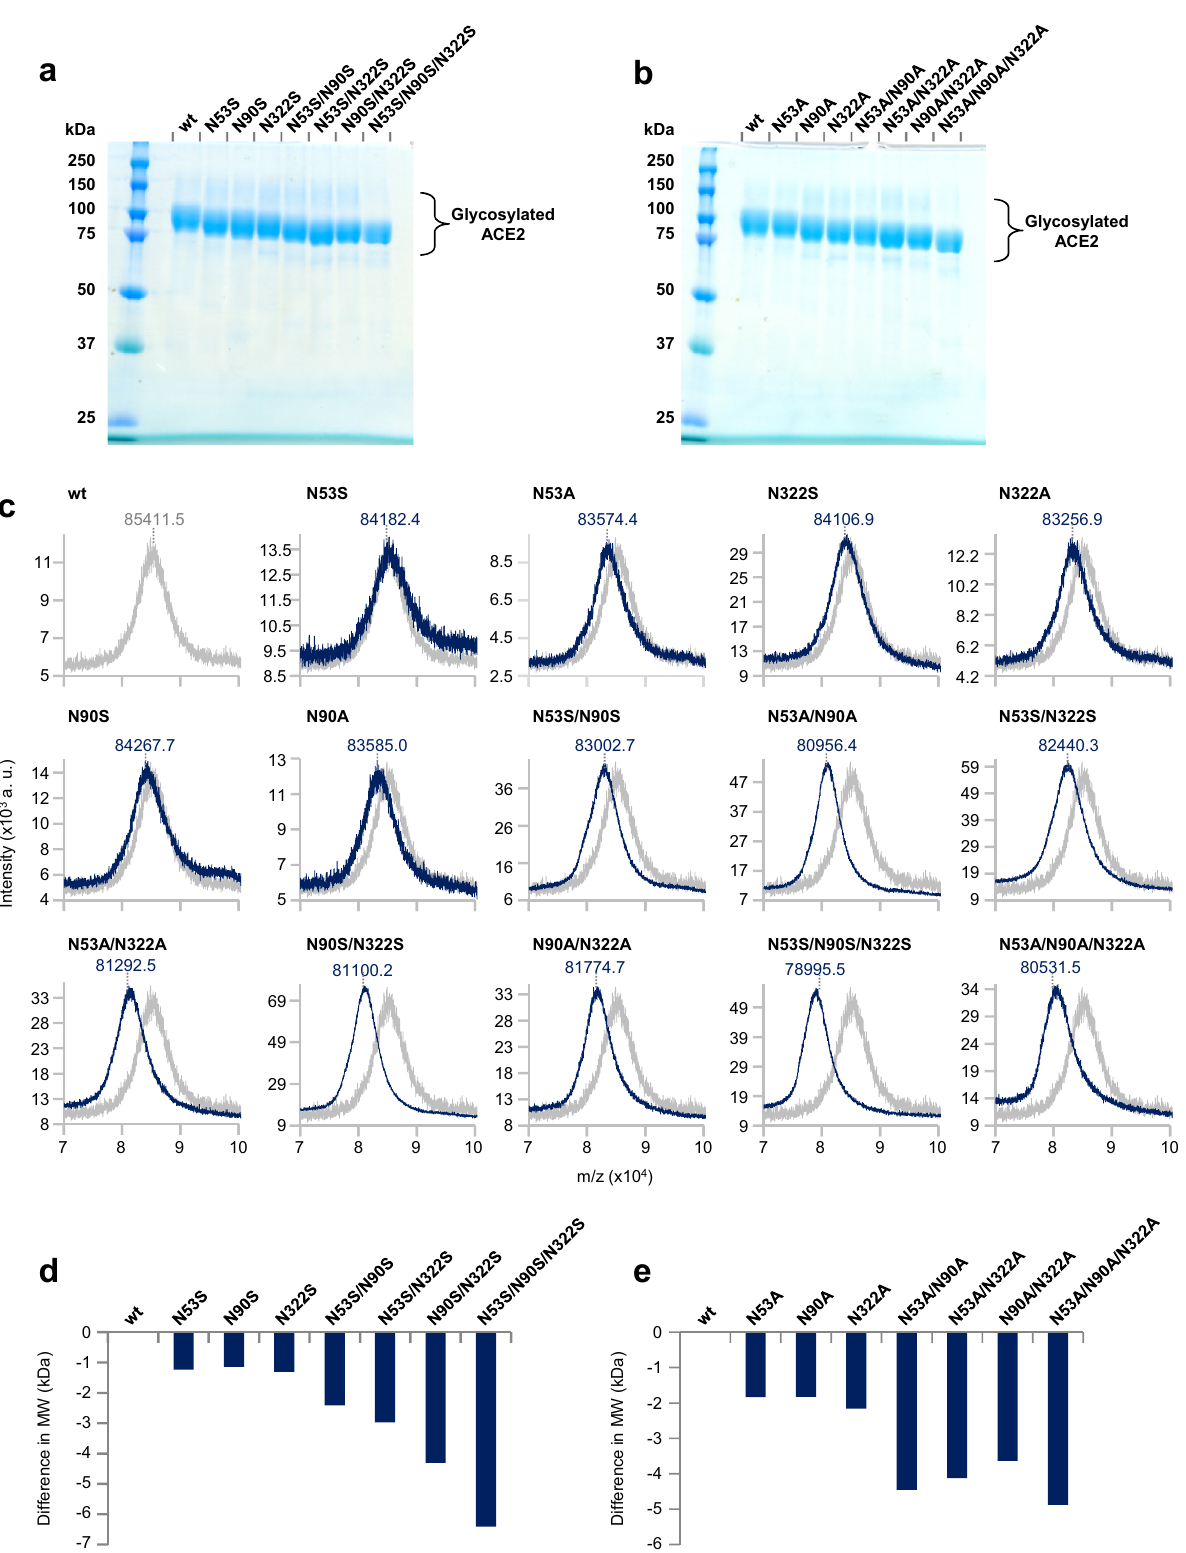
Fig. 2 Preparation of soluble hACE2 glycan deletants. a , b SDS-PAGE with Coomassie blue staining of puri fi ed recombinant shACE2 wt and the glycan deletants for N-to-S substitution ( a ) and N-to-A substitution ( b ). c MALDI-TOF mass spectra of shACE2 wt (light gray) and the glycan deletants (dark blue). Mass spectra were obtained in the range from 15,000 to 120,000 m/z, and the mass regions from 70,000 to 100,000 m/z that contained + 1 ions of shACE2 are depicted. Values on the top of the peaks are centroids of the peaks that correspond to the molecular weight of each shACE2 protein. d , e Size differences in the average molecular weight between shACE2 wt and the glycan deletants for N-to-S substitution ( d ) and N-to-A substitution ( e ). Representative data and images from two experiments with different protein preparations are